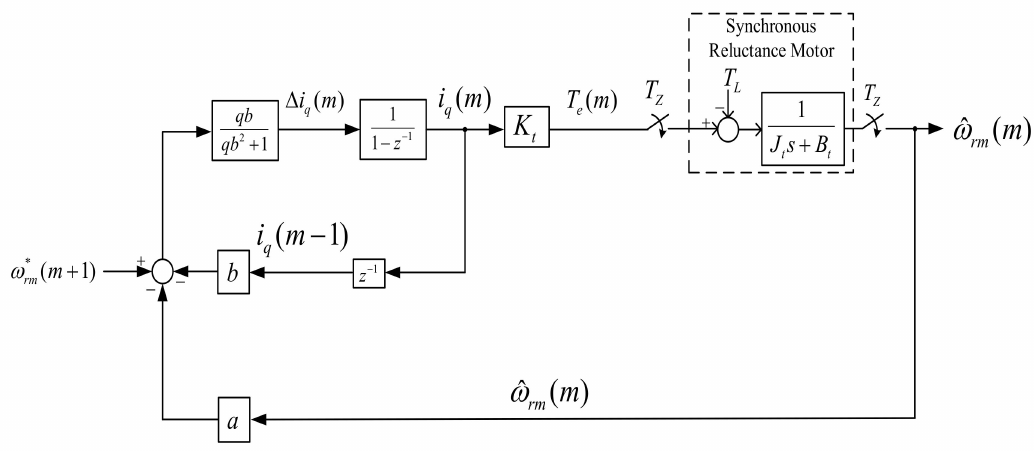
Figure 4. Block diagram of predictive speed